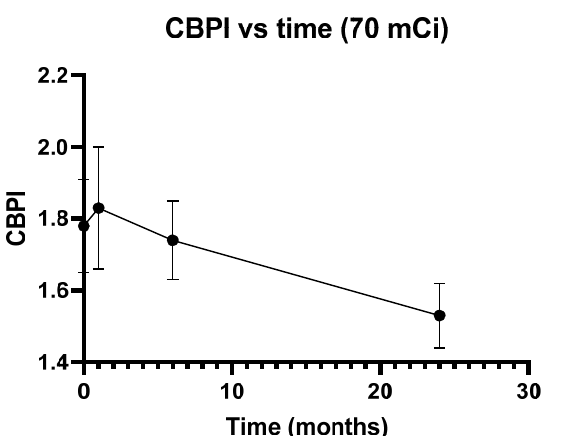
Figure 2. Cytokinesis-Block Proliferation Index (CBPI) (mean ± S.D.) in DTC patients before and after (1, 6, and 24 months) therapy with 131 I (70 mCi).